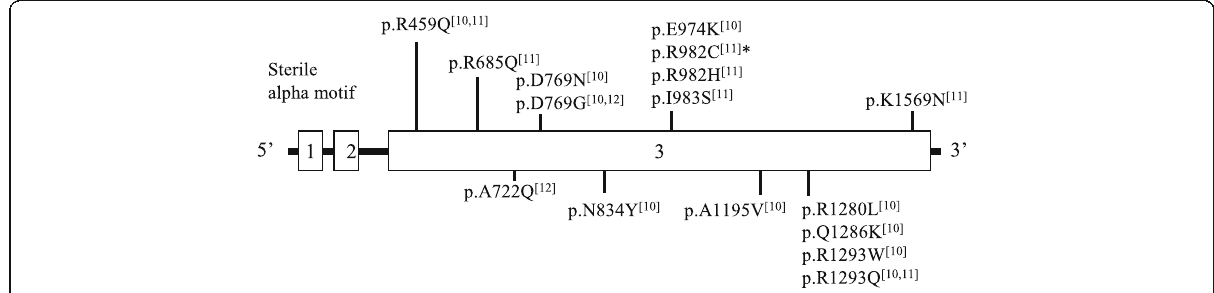
Fig. 1 Mutation spectrum of SAMD9 gene in patients with MIRAGE syndrome. *, a mutation in the current